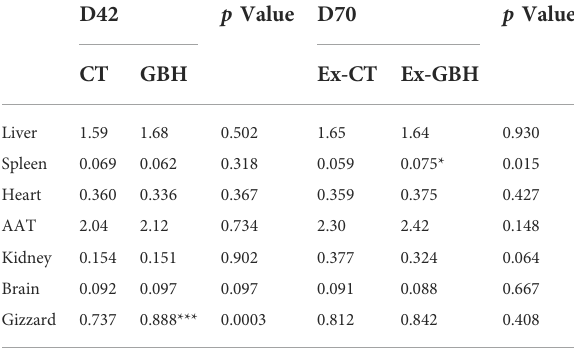
TABLE2Hensorganindex[Tissueweight(g)×100)/(Bodyweight(g)]in GBH exposed and control animals during the period of exposure (42nd day of protocol, D42, CT n = 9, GBH n = 9) and after GBH exposure (70th day of protocol, D70, Ex-CT, n = 12, Ex-GBH, n =